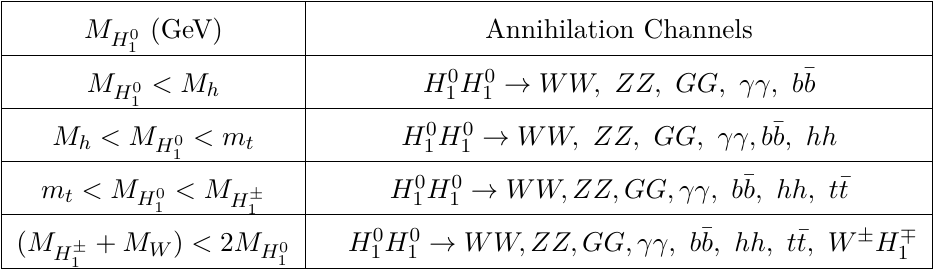
for different scalar dark matter 1